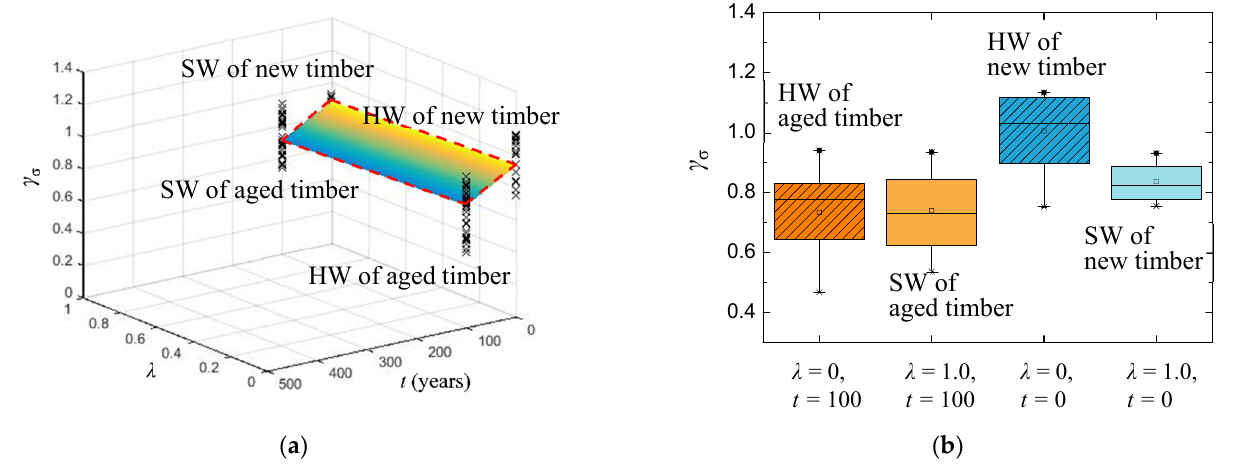
Figure 6. Distribution of the compressive strength ratio: ( a ) γ σ in 3D space; ( b ) boxplot of γ σ .